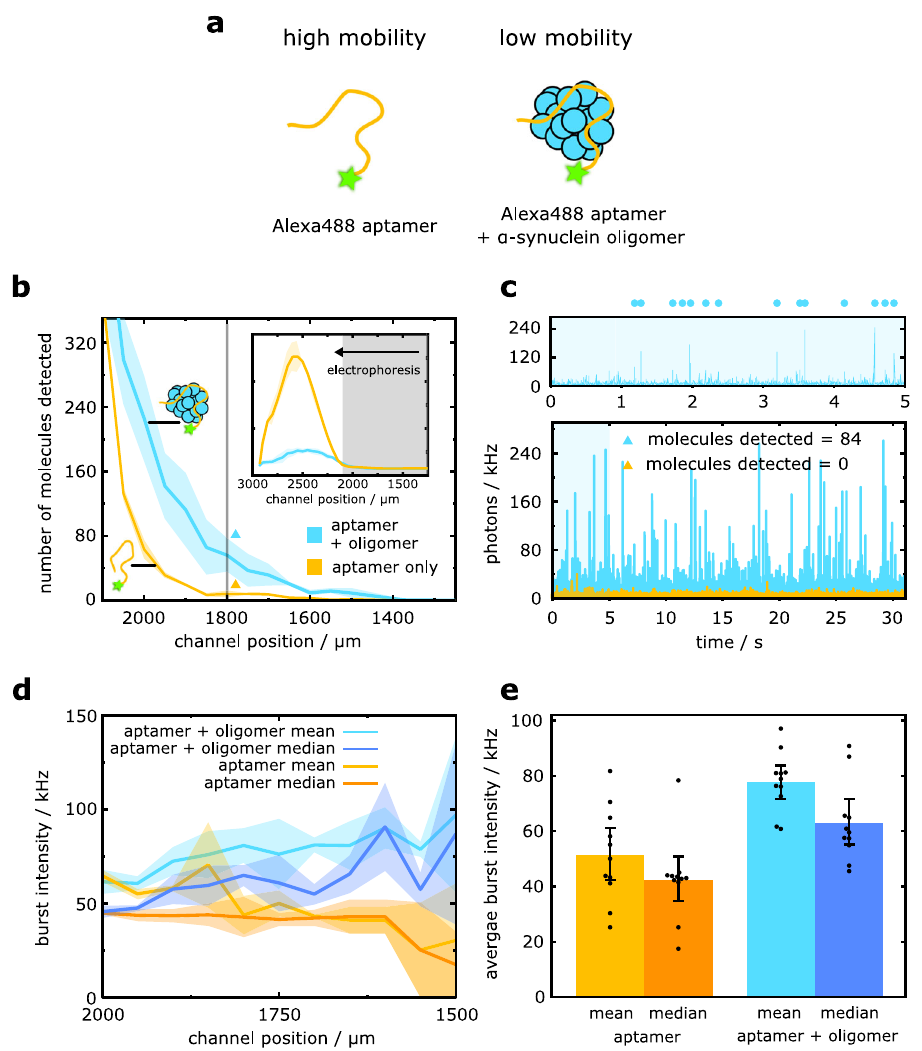
Fig. 5 | Sensing and immunochemical analysis of α -synuclein oligomers. a The binding of an aptamer to wild-type α -synuclein oligomers reduces the electro- phoretic mobility of the probe, allowing for the discrimination between oligomer- boundandunboundaptamerspecies. b Electropherogramasobtainedbyscanning oftheconfocalvolumeacrossthecross-sectionofthechannelinastepwisemanner for the α -synuclein oligomer – aptamer sample (blue line; average of N =3 repeats) and for the free aptamer probe (orange line; average of N =3 repeats).The shaded bands correspond to the standard deviation. The main panel depicts the region where single-molecule counting of the probe or oligomer – probe complex is pos- sible. This region was used to estimate the concentration of oligomers in the sample. The inset shows the full electropherogram and the average photon intensity ateach steplocation, with the region shaded ingrey depicting the region shown in the main panel. c Exemplary photon-count time traces for the control sample (orange) and the sample mixture (blue) at the position indicated with